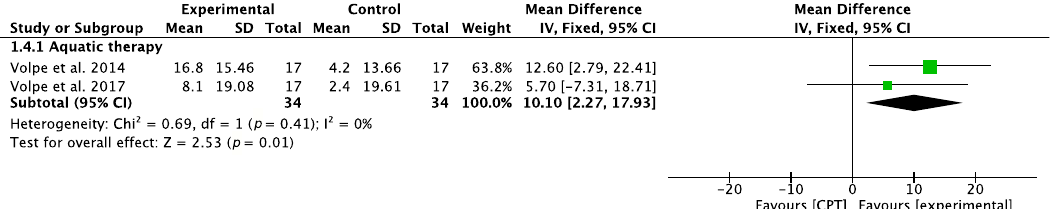
Figure 5. Forest plot for balance confidence measured by ABC. Green block indicates the weight assigned to the study and the horizontal line depicts the confidence interval. Black rhombus shows the overall result. The bold words highlight the total/subtotal values and the different modalities of therapies used in the interventions.